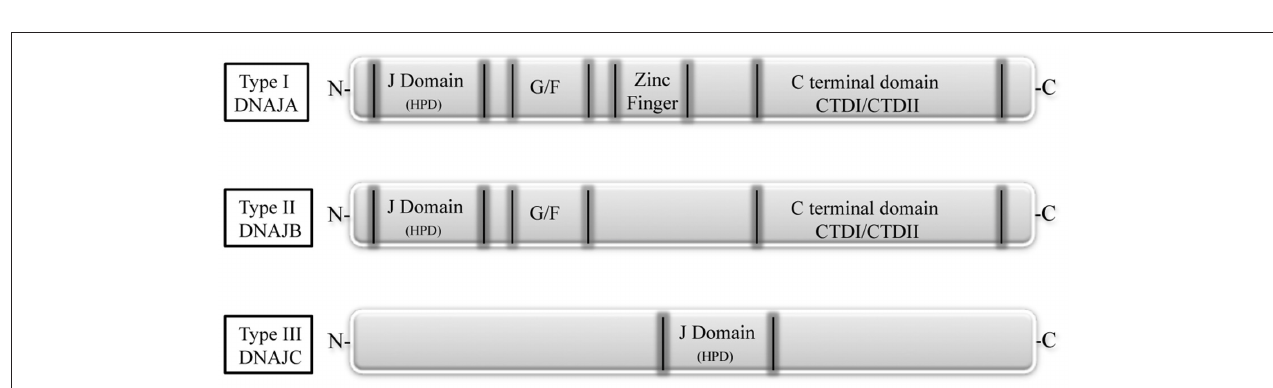
FIGURE 1 | The Hsp40-Hsp70 cycle. Hsp40 co-chaperone forms complexes with unfolded or non- native proteins delivering them to Hsp70. The interaction between Hsp40 and the ATP-bound Hsp70 takes place through the J-domain. The client protein transiently interacts with the Hsp70 and the interaction is stabilized by a conformational change in Hsp70 caused by the hydrolysis of ATP which, in turn, is stimulated by both Hsp40 and client protein. Hsp40 is then released. A nucleotide exchange factor (NEF) then binds Hsp70 (having more affinity for the ADP-bound form compared to the ATP form), stimulating the dissociation of ADP through a conformational change in Hsp70. An ATP molecule is bound again to Hsp70 because of its higher cellular concentration, causing the release of the client protein. The system is then ready for a new cycle ( Kampinga and Craig, 2010).